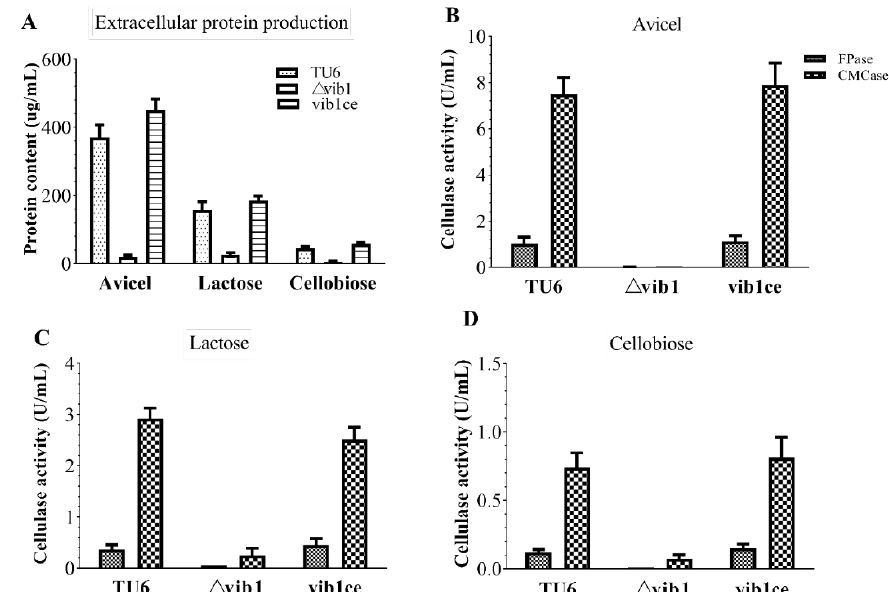
Figure 1. The effect of Vib1 on extracellular protein production and cellulase activity under different carbon sources. Parent strain TU6 and the vib1 deletion mutant ( ∆ vib1), together with the vib1 constitutive expression strain (vib1ce), were precultured in glucose-containing MM for 30 h; thereafter, the pre-grown mycelia were equally shifted to MM with Avicel cellulose, lactose, or cellobiose as the sole carbon source and continued cultivation for 120 h. The supernatants were collected for measuring extracellular protein content ( A ) and the volumetric cellulase activity ( B – D ). The values were means from three biological replicates. Error bars denoted standard deviations.